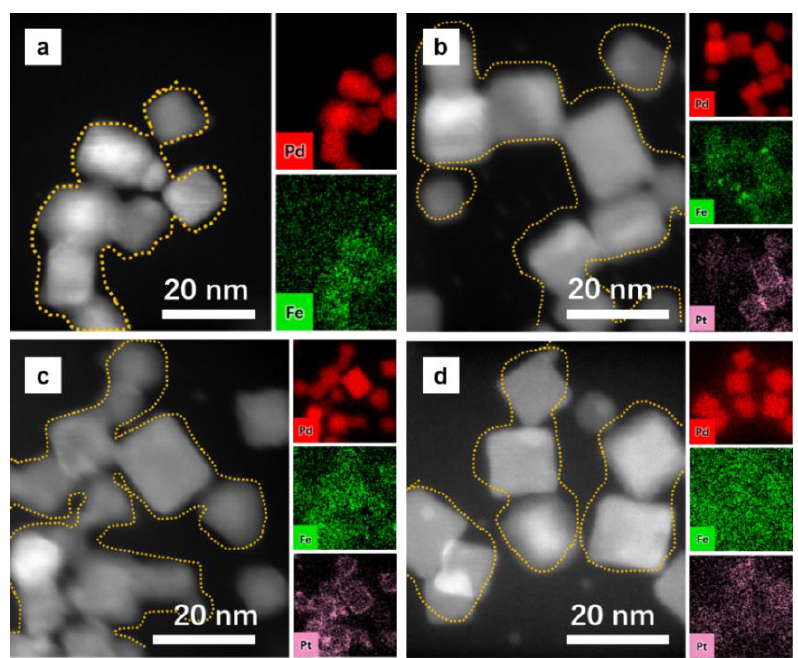
Figure 2. Energy-dispersive X-ray spectroscopy (EDS) mapping images of ( a ) Pd@Fe, ( b ) Pd@FePt 3/1 , ( c ) Pd@FePt 1/1 , and ( d ) Pd@FePt 1/3 .